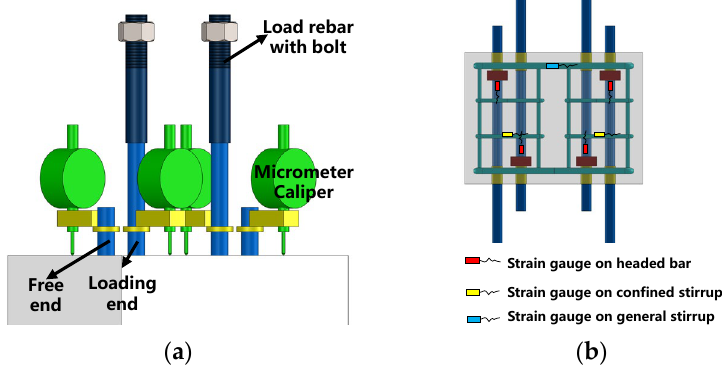
Figure 5. Measurement system ( a ) Measurement of slip; ( b ) Strain gauge layout.